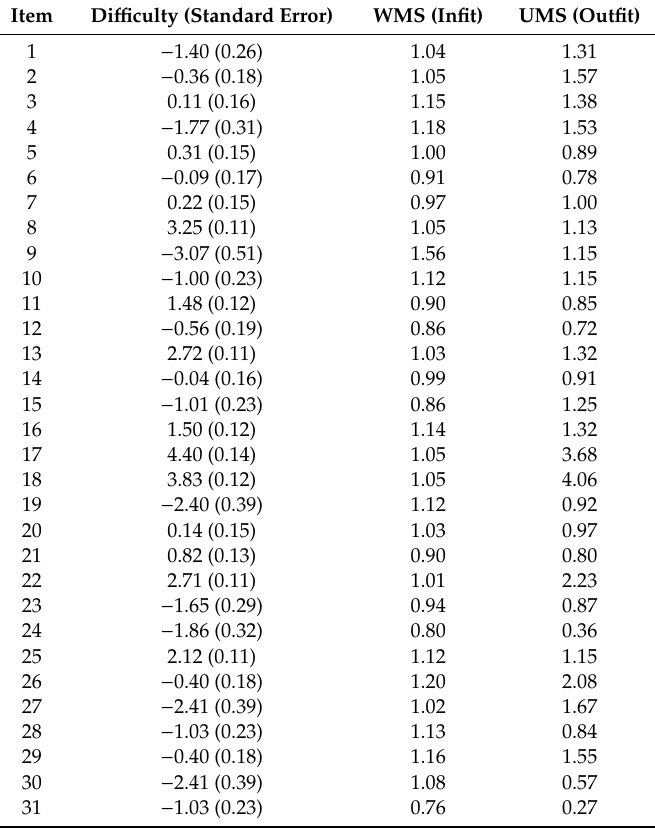
Table 2. Rasch model for the Pressure Injury Prevention Knowledge (PIPK) questionnaire with 31 items. Item Di ffi culty (Standard Error) WMS